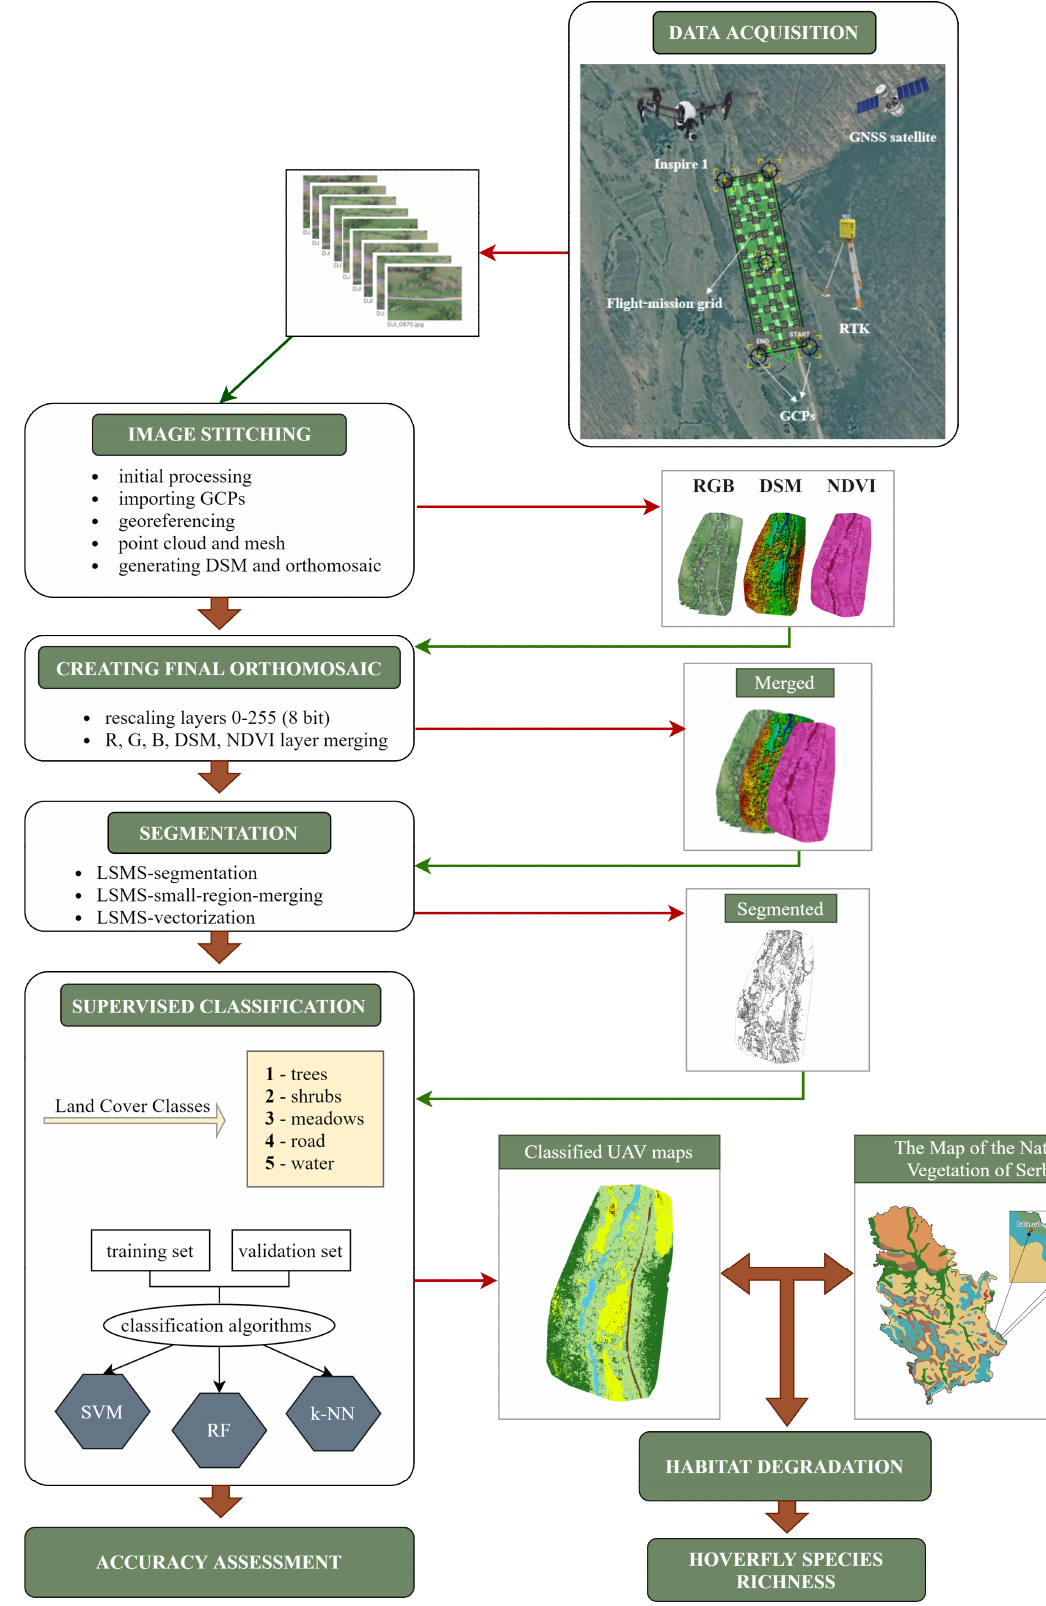
Figure 2. Flowchart of the overall